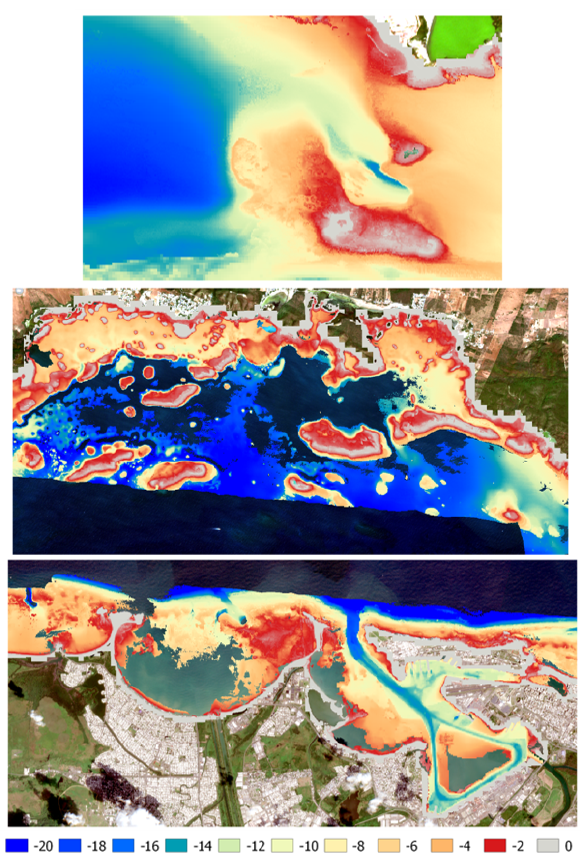
Figure 2. In-situ depth acquired from Lidar or MBES. From top to bottom: Ponce, Southwest, San